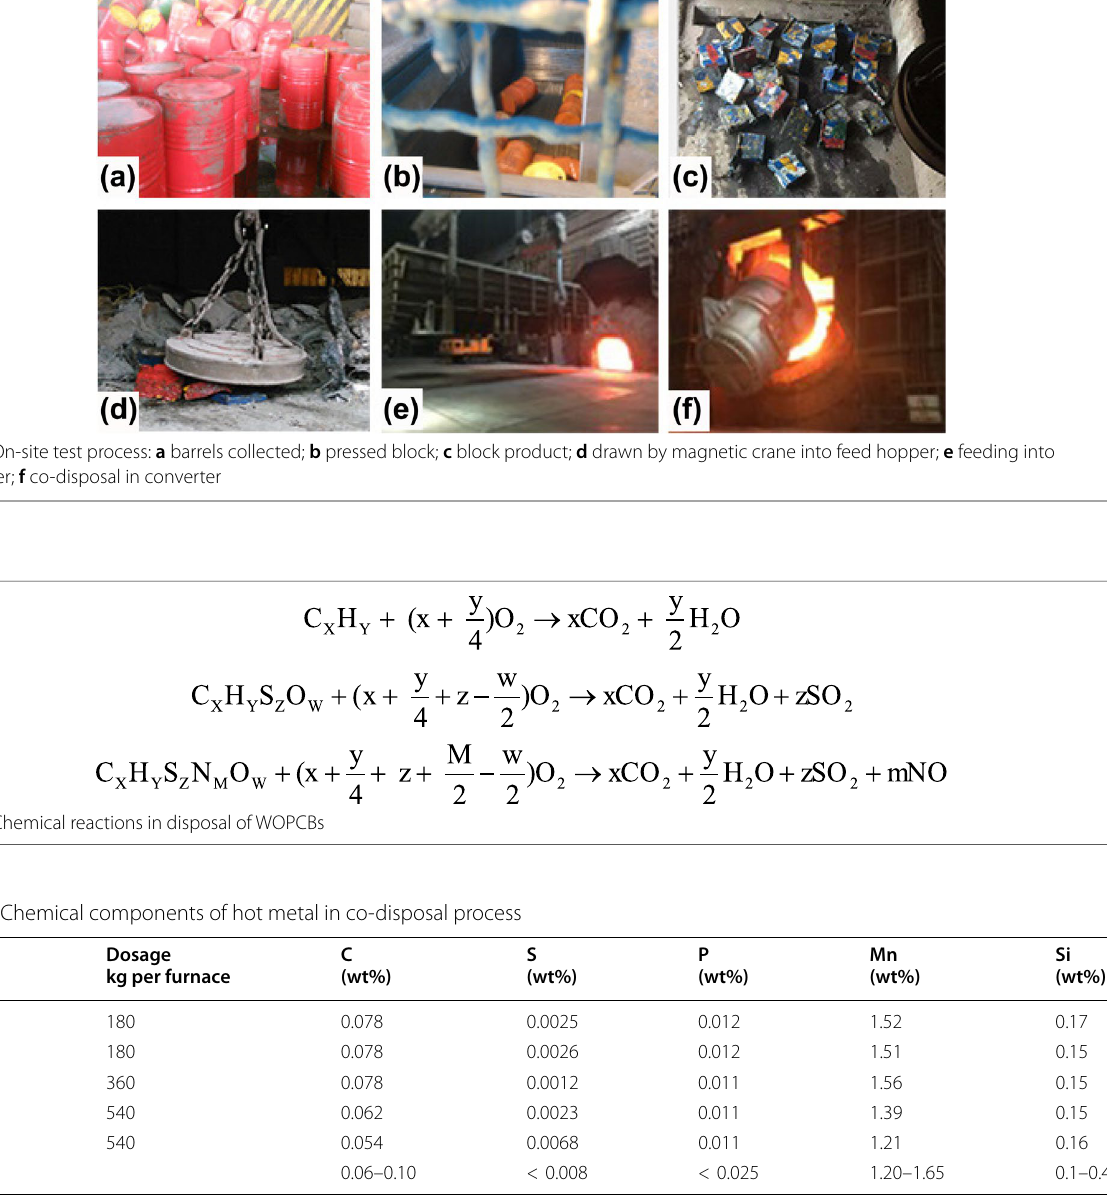
a The element standard of desulfurization steel in WISCO